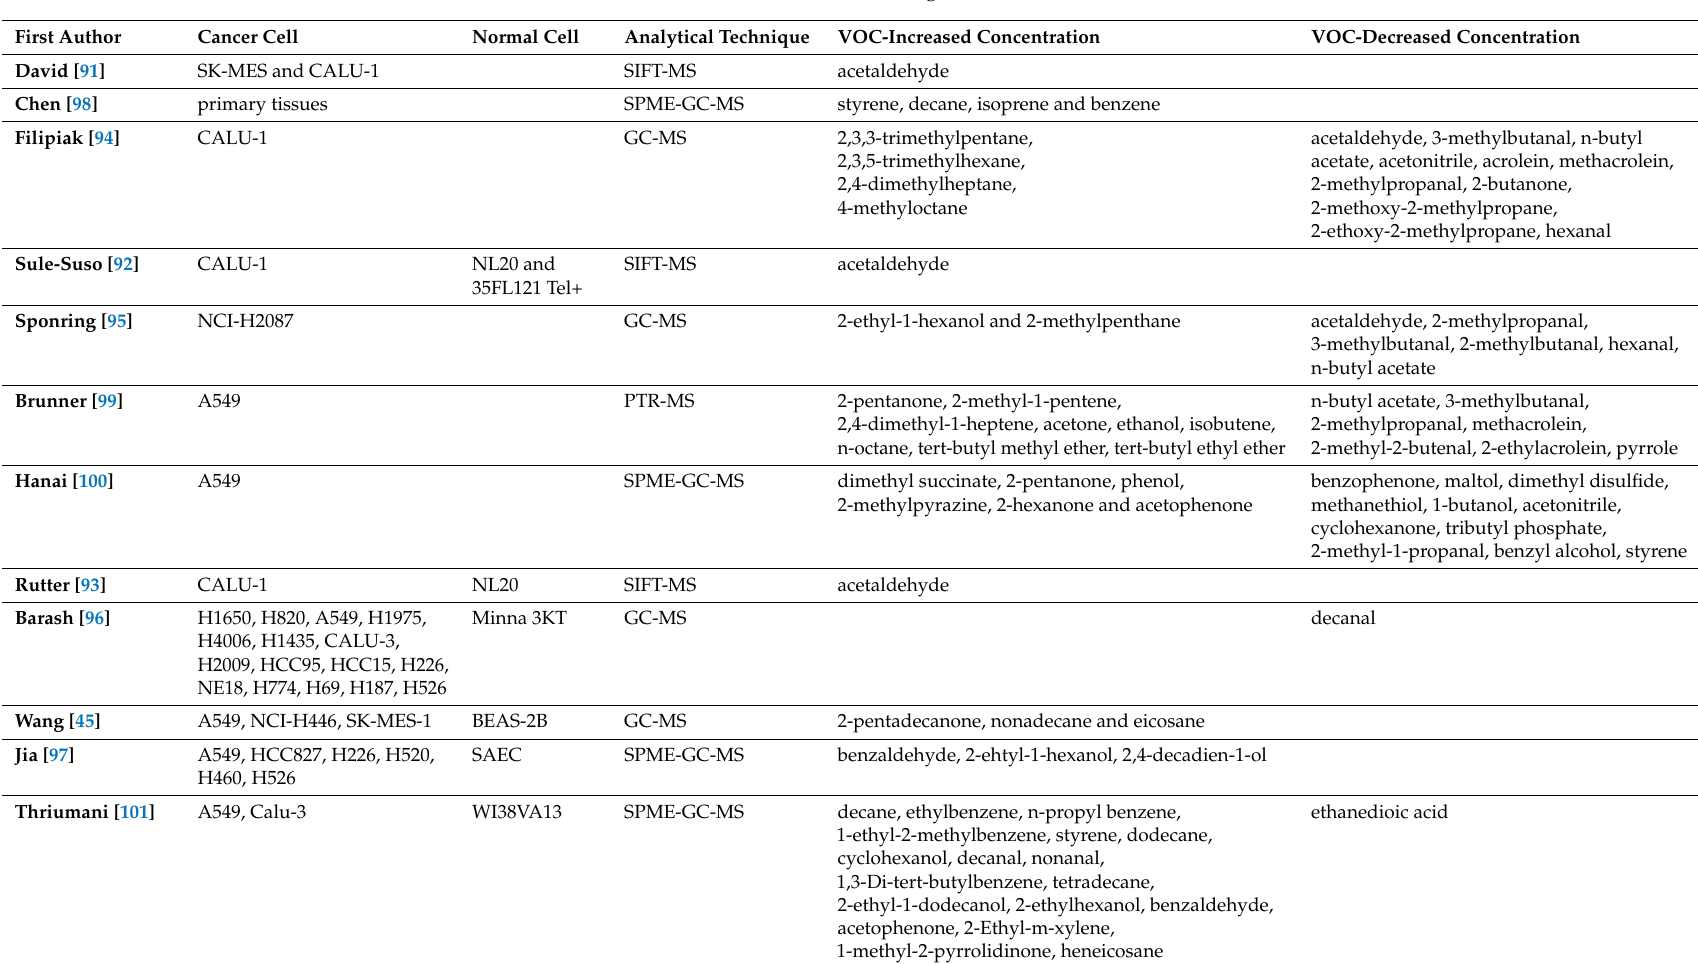
Table 3. Identified volatile biomarker of lung cancer from in vitro